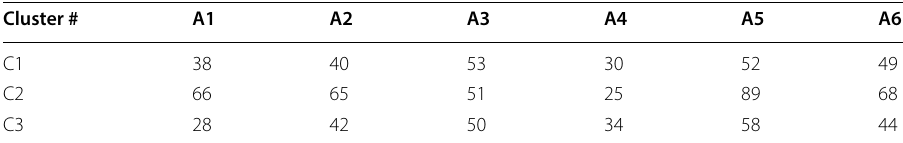
Table 18 PACM Matrix Cluster #